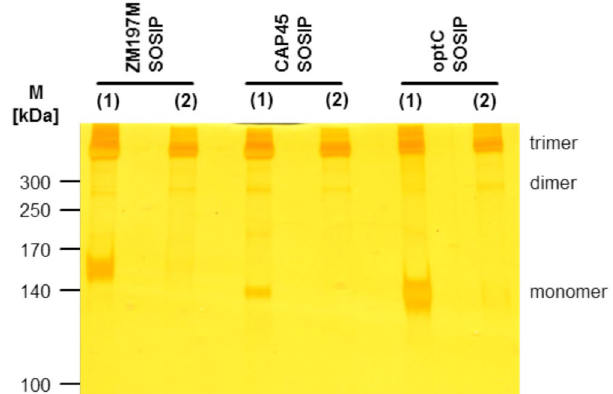
Figure 1. Silver staining of purified ZM197M, CAP45 and optC gp140 SOSIP proteins. Indicated Env gp140 SOSIP proteins are shown after lectin purification ( 1 ) followed by additional size exclusion and anion exchange chromatography purification steps ( 2 ). The gel was cropped below the 100 kDa marker and the marker lane was substituted by indicating the molecular weights of the marker proteins. The original gel is shown in Suppl. Figure 1a (1) together with the individual fractions collected after SEC and AEC for the three SOSIPs (2) to (4).